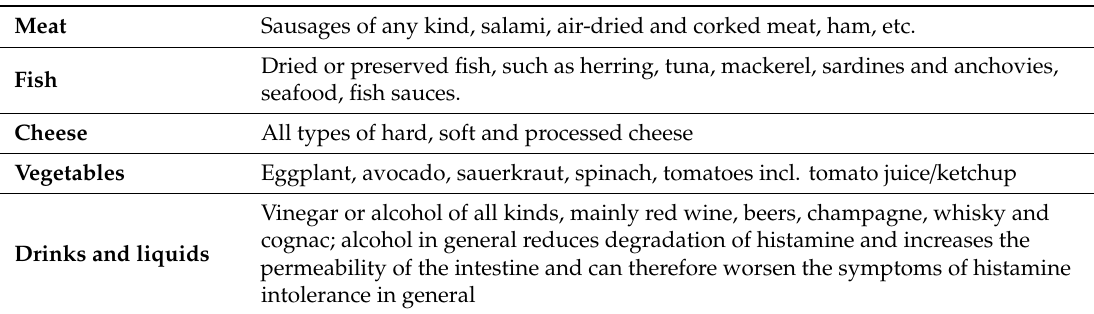
Table 1. Foods containing histamine [56].